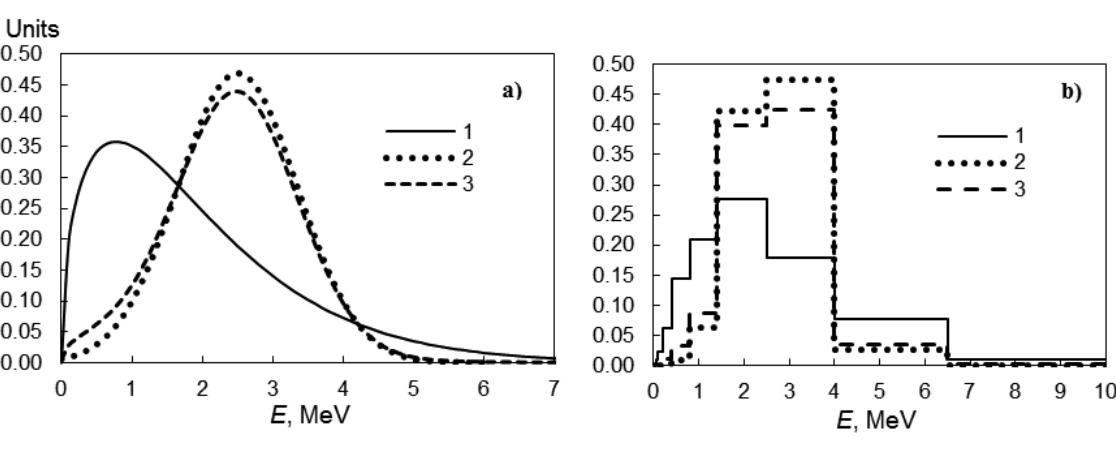
Figure 2. Normalized distribution of the continuous (a) and the 28-group spectrum (b) of neutrons: 1 – spontaneous fission; 2 – ( α,n)-reactions; 3 – total